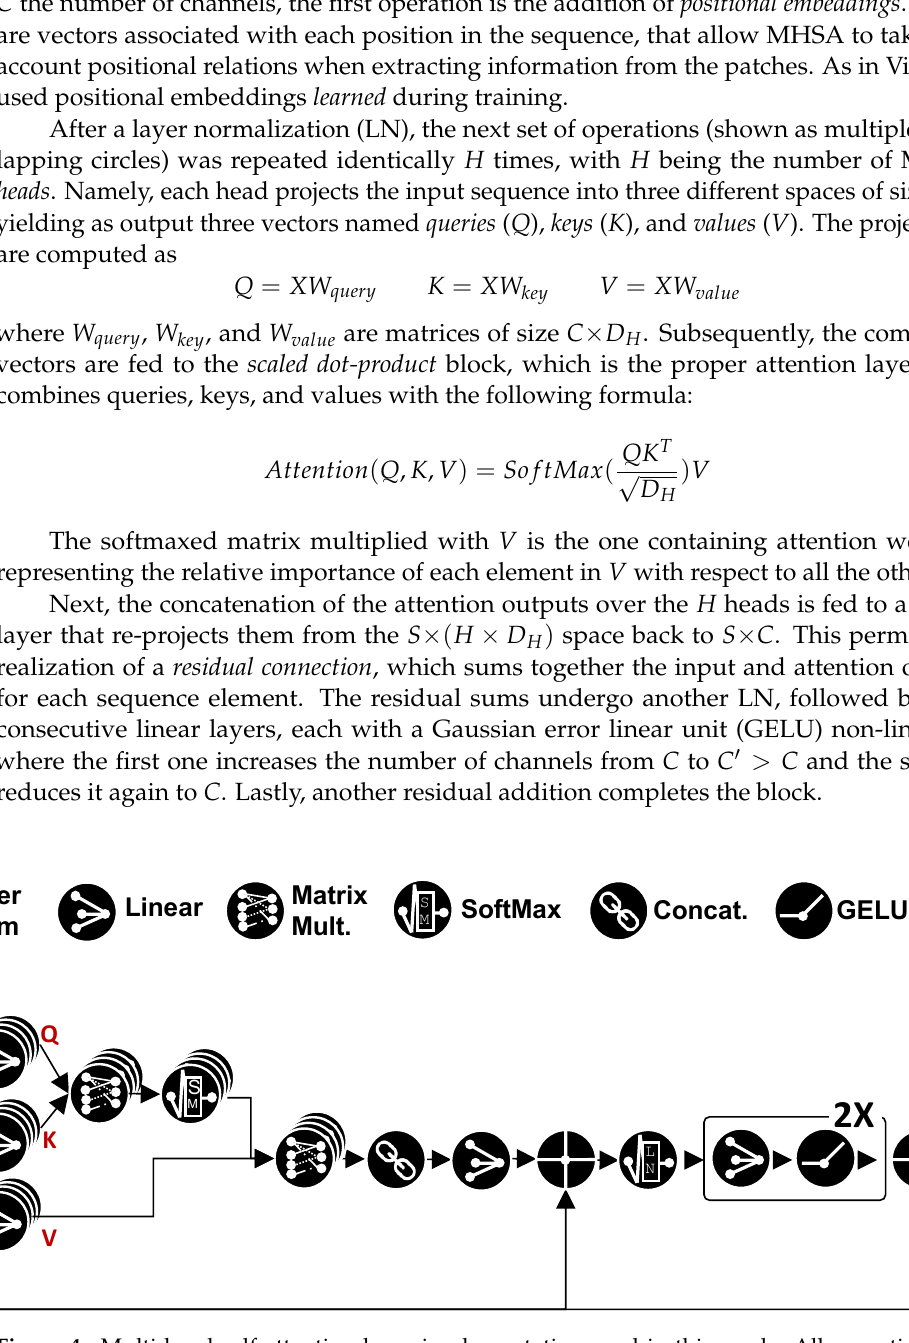
Figure 4. Multi-head self-attention layer implementation used in this work. All operations are applied to the entire sequence of input